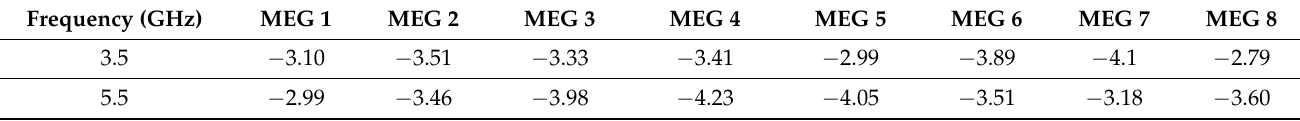
Table 1. Mean Effective Gain of proposed MIMO